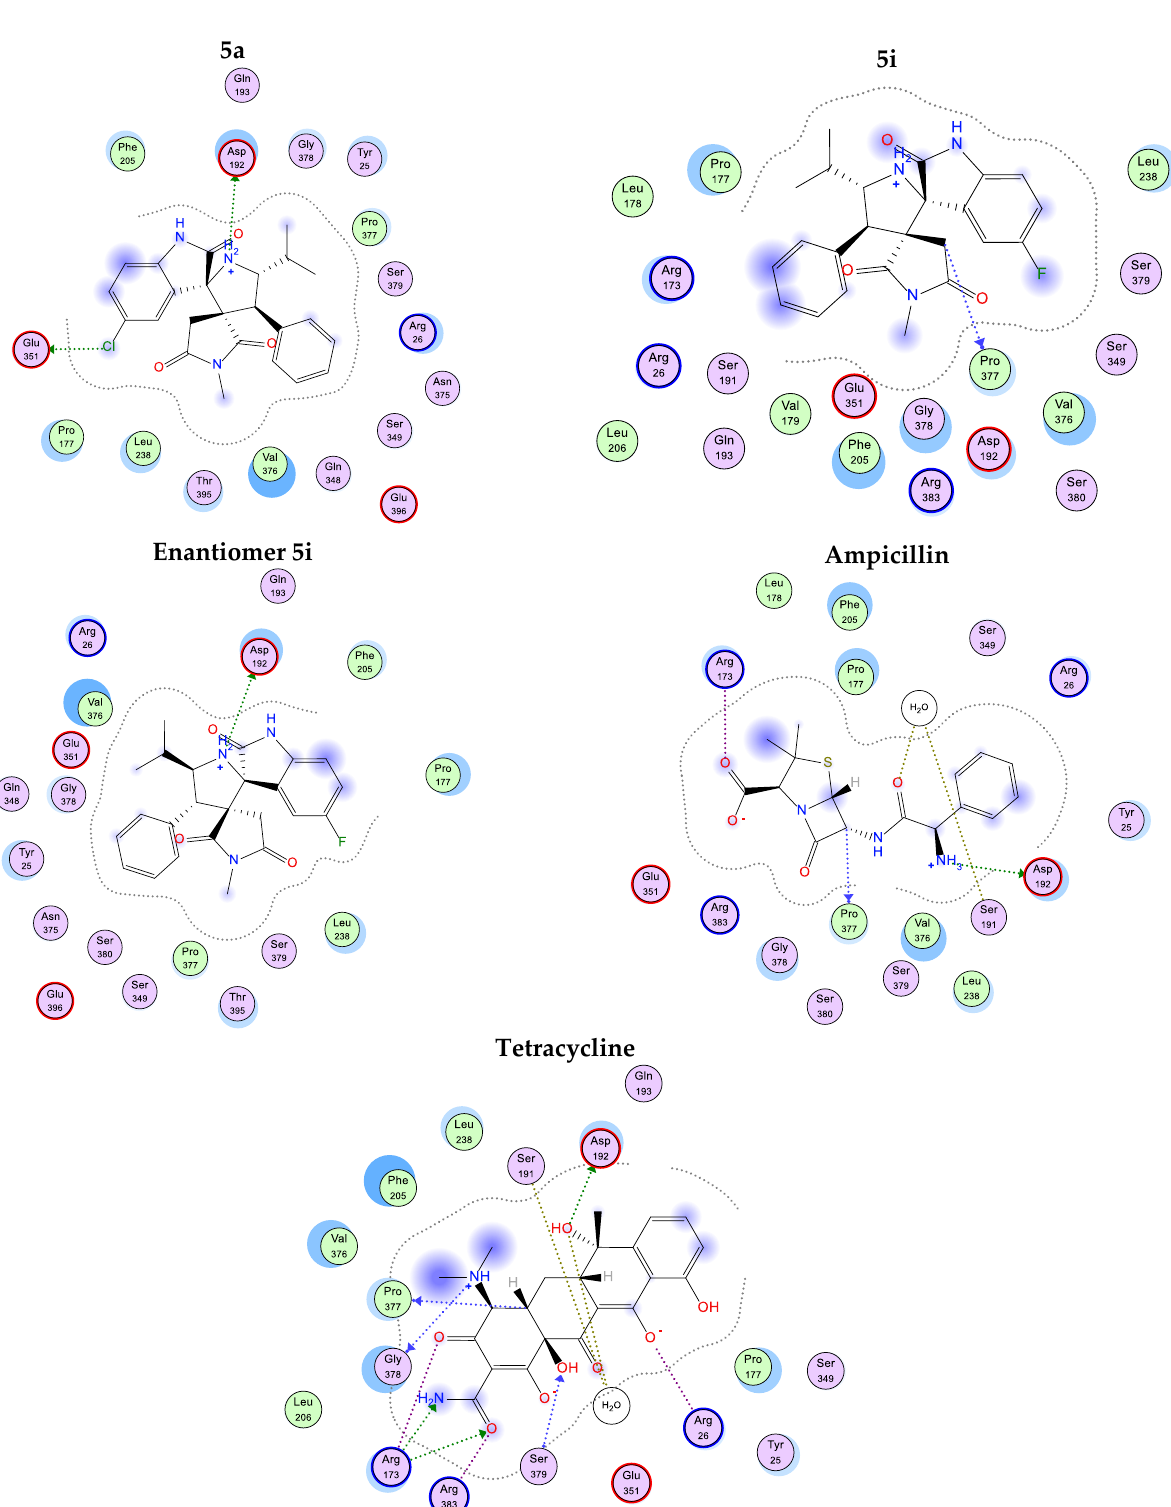
Figure 8. 2D-interactions of compounds 5a , 5i, 5i enantiomer , Ampicillin and Tetracycline with amino acid residues on glucosamine 6-phosphate synthase (1jxa).